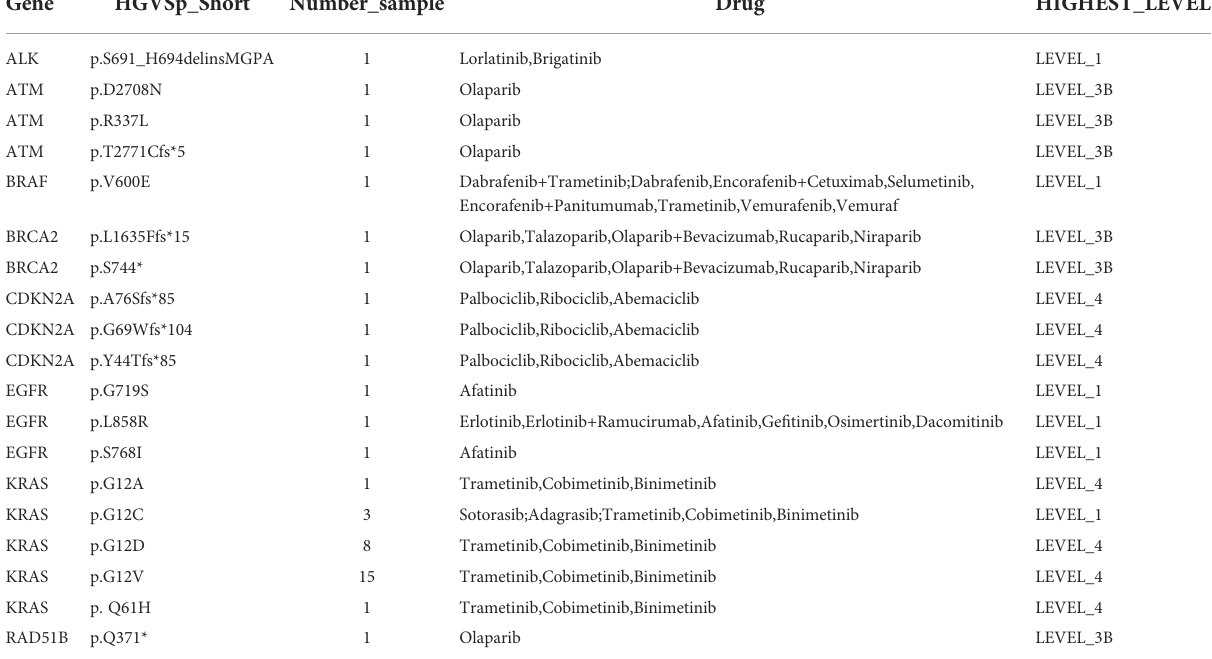
TABLE 3 The targetable mutations and possible drugs in